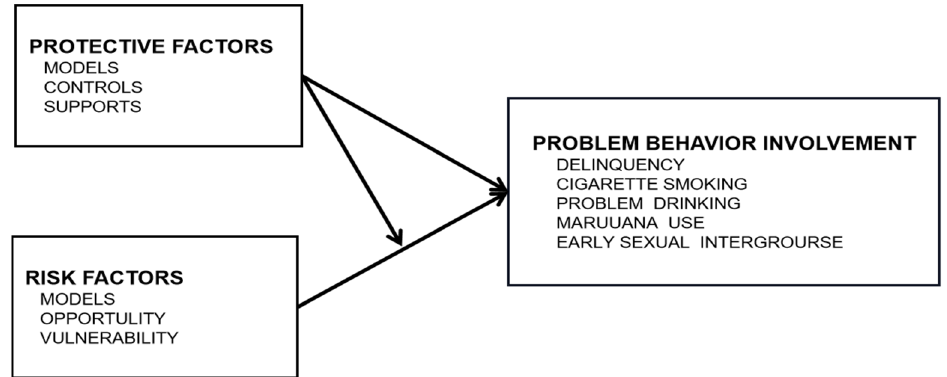
Figure 1. The comprehensive theoretical model of problem